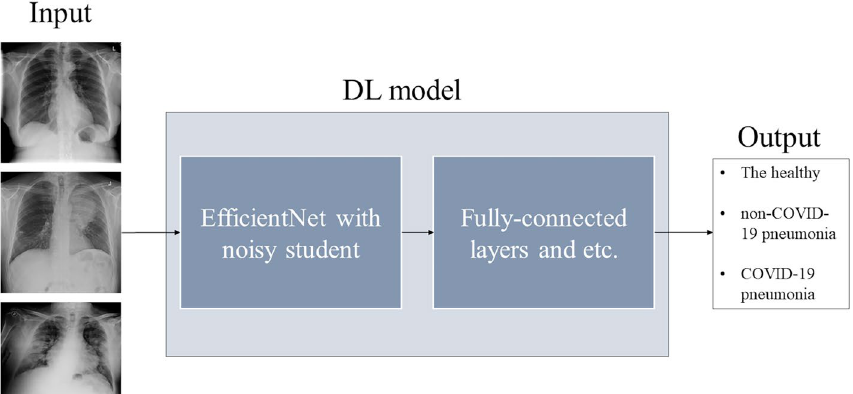
Figure 1. Our DL model. Abbreviation: DL, deep learning.